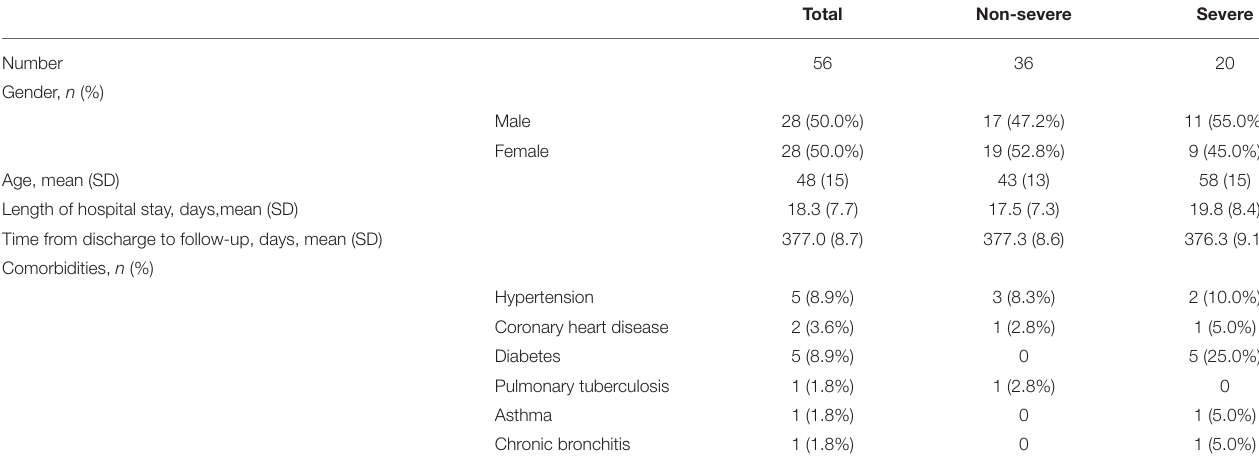
TABLE 1 | Baseline clinical